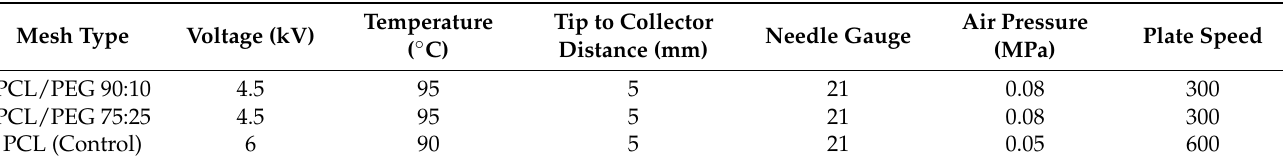
Table 1. MEW parameters of PCL and PCL/PEG composite